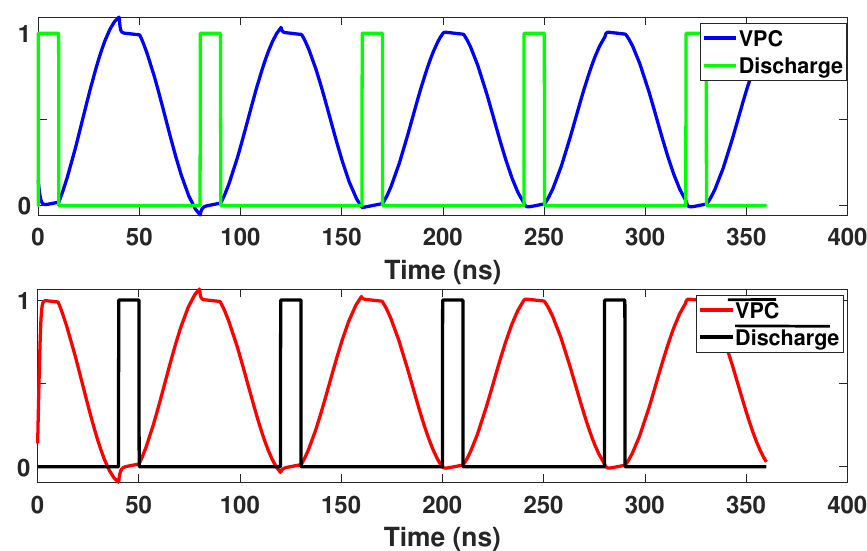
Figure 10. CPA-resistant two-phase adiabatic logic clocking scheme used in EE-ACML